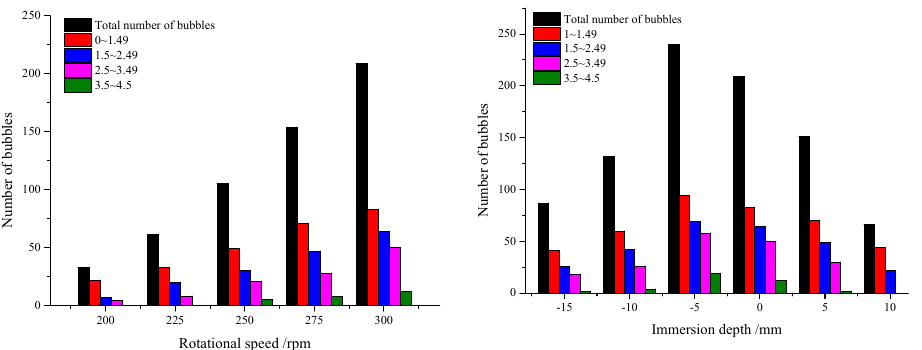
Figure 6. Number of bubbles in different conditions. ( a ) Number of bubbles in different rotational speeds; ( b ) Number of bubbles in different immersion depths.